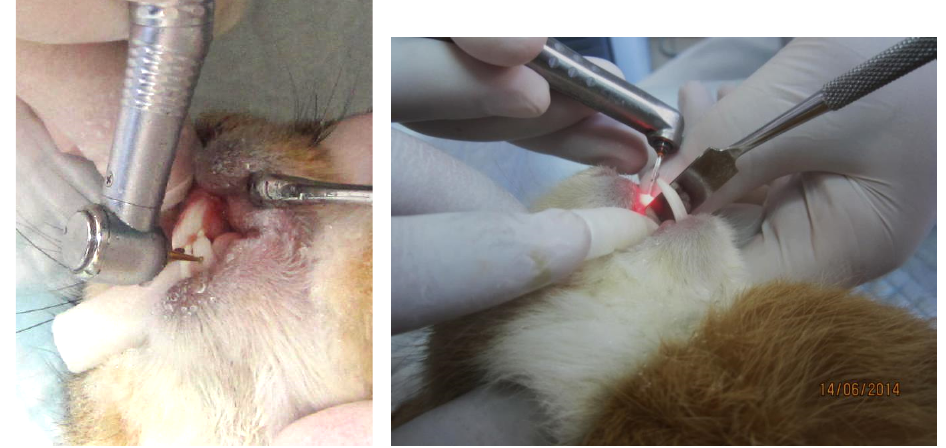
Figure 2. Pulp exposure with rotating instruments Figure 3. Pulp exposure with Er-YAg